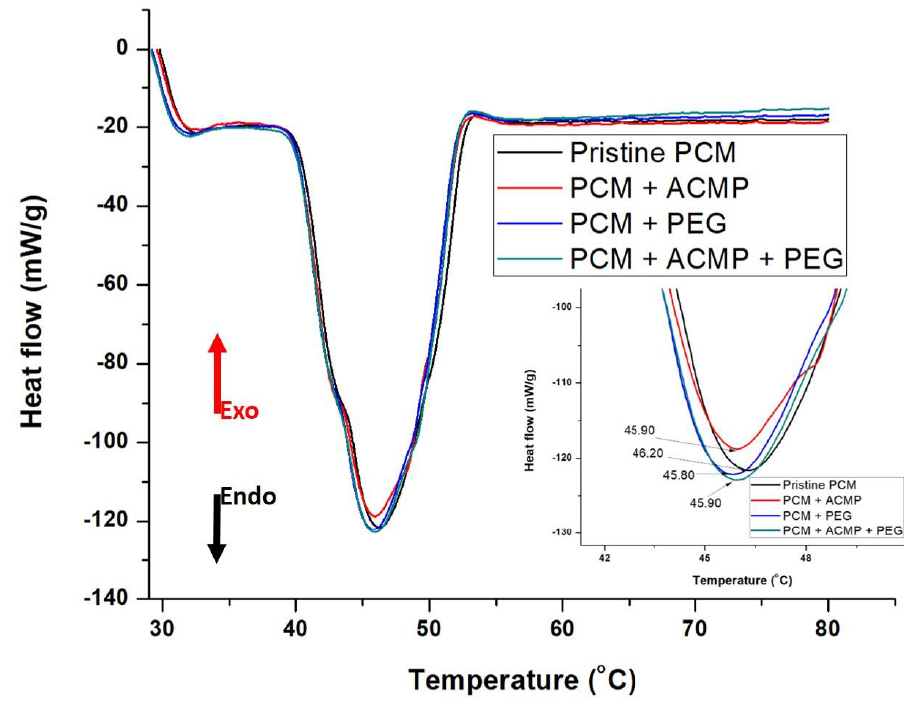
Figure 7. DSC curves of pristine PCM and PCM with additives with optimum compositions. The melting temperature of pristine PCM, PCM + ACMP, PCM + PEG, and PCM +